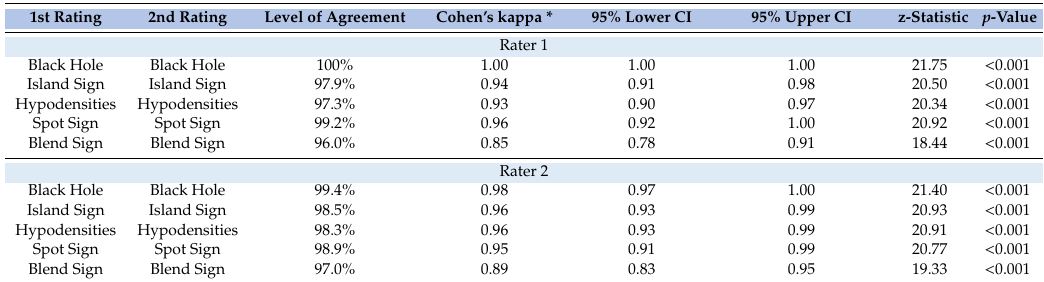
Table 5. Intrarater agreement of two readings stratified across two raters.